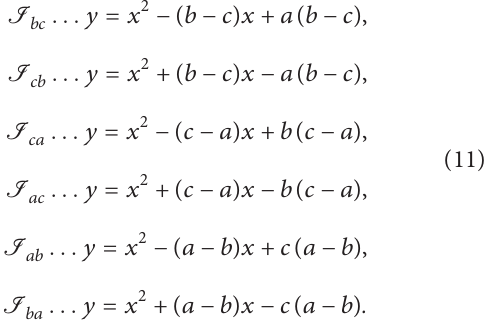
Figure 2: Visualization of statements of theorems 2 and